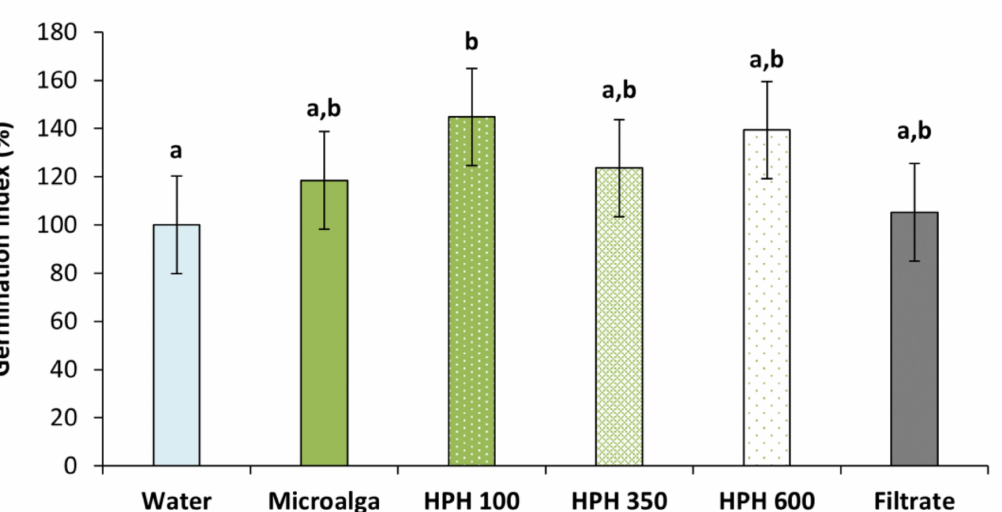
Figure 5. Germination index of wheat plants treated with Tetradesmus obliquus after high-pressure homogenization at 100, 350, and 600 bar (1 cycle) and non-disrupted microalga culture, and its filtrate, compared to distilled water (control). Different letters indicate significant differences among treatments (Tukey’s test, p < 0.05) and data are shown as mean ± pooled standard deviation ( n =